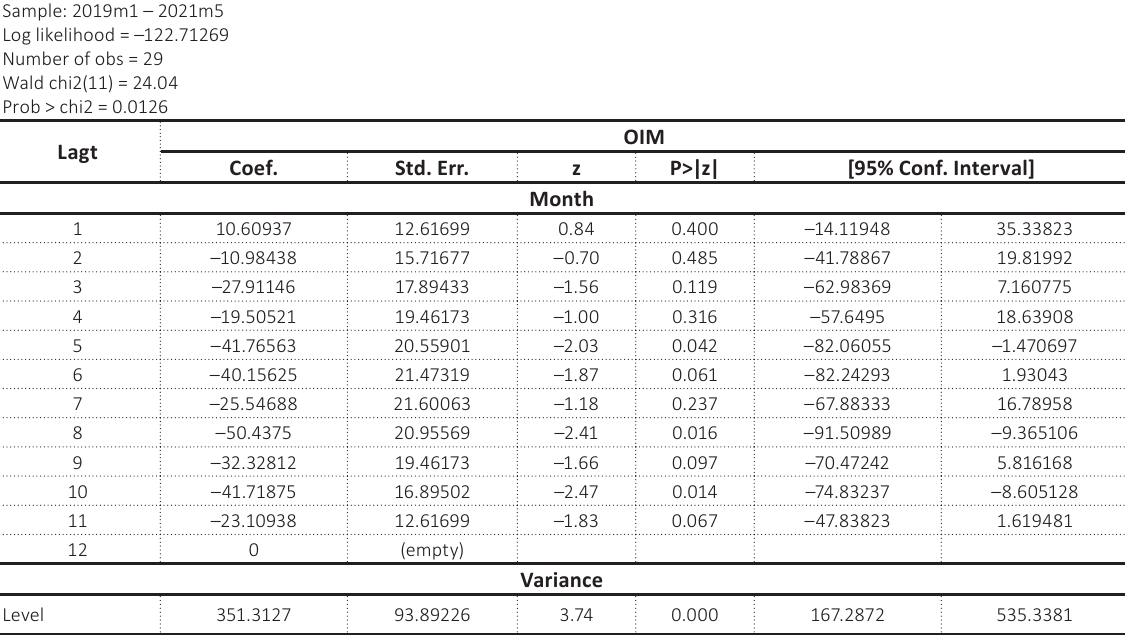
Table 4. Stata output from fitting the second unobserved-components model Sample: 2019m1 – 2021m5 Log likelihood = –122.71269 Number of obs = 29 Wald chi2(11) =